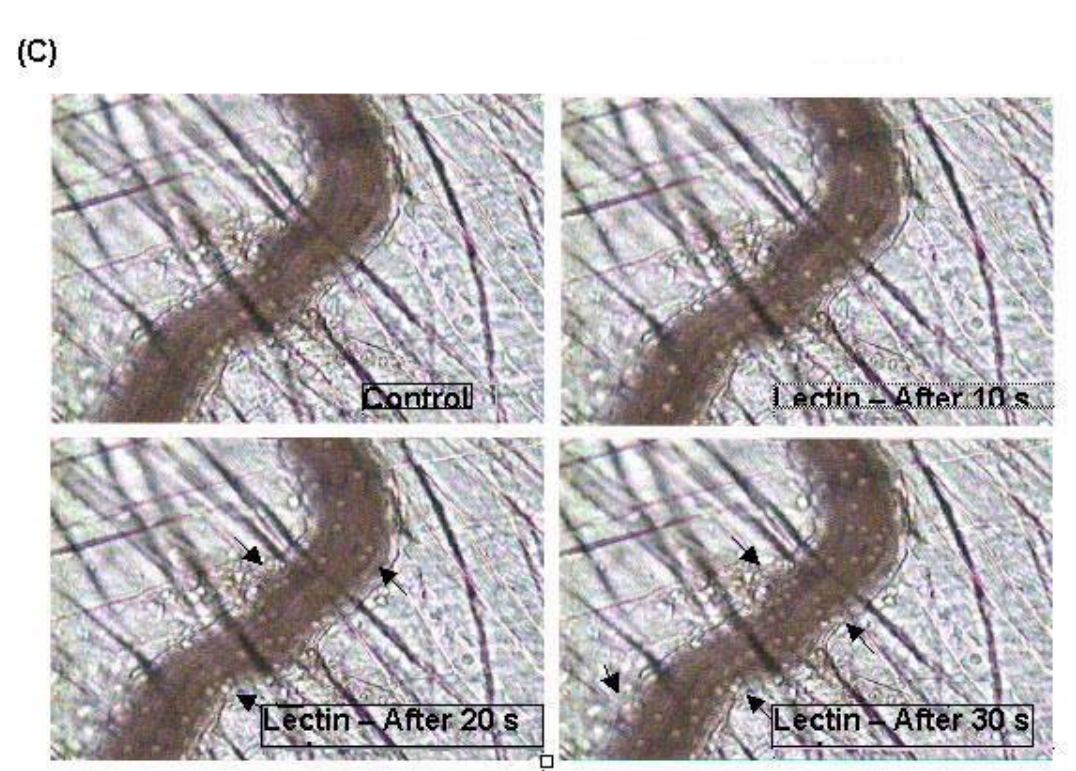
Figure 5. Evaluation of the kinectics of rolling and adherent leukocytes. Samples (30 μ l) containing 5 μ g lectin were topically applied on the cremaster muscle of anesthetized mice. The aspect of pre and postcapillary venules was observed every 10min during 30min and rolling (A) and adhesion (B) were recorded during 1min. The photos represent an intravital micrograph of cremaster muscle after 0, 10, 20 and 30s of topical application of lectin (C). Arrowheads indicate adhered leukocytes. * p < 0.05, compared with control